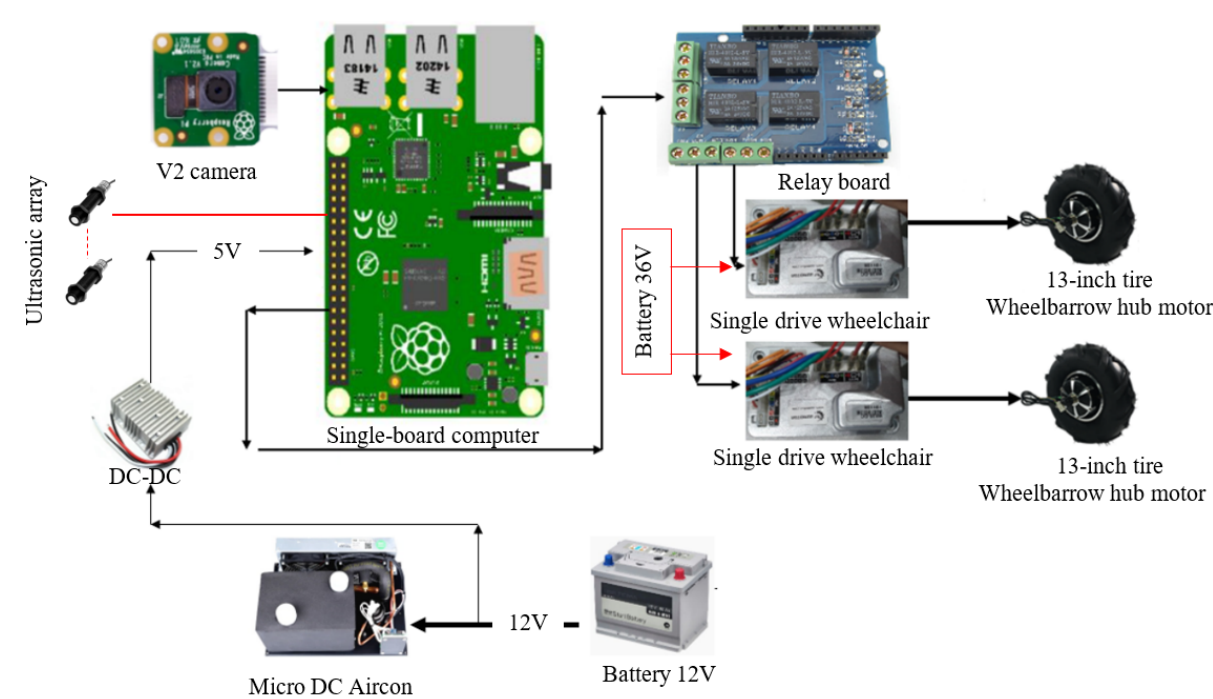
Figure 4. Schematic diagram for the whole